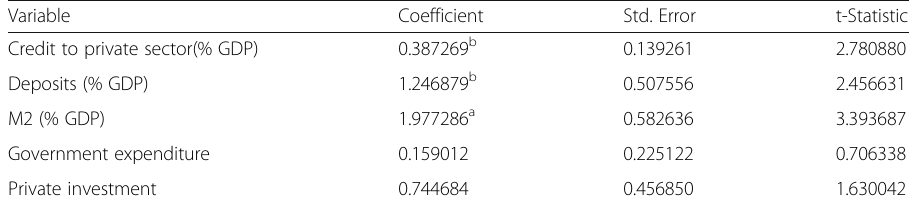
Table 6 ARDL coefficients for